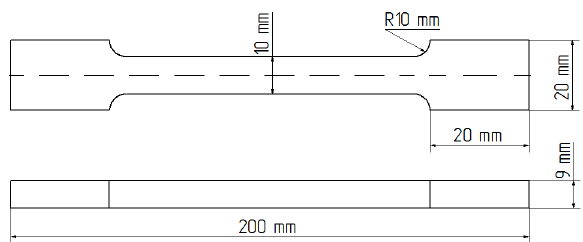
Figure 2. Dimensions of the adhesive specimens used for strength testing.